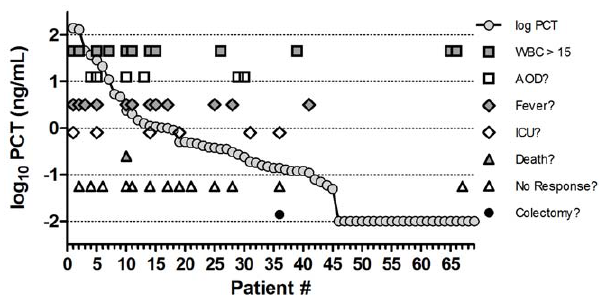
Figure 2. Procalcitonin (PCT) levels and presence of severity markers. This graph shows that patients with elevated PCT levels have an abundance of severity markers, while those with low or undetectable PCT levels have few. Patients are ordered by decreasing log 10 PCT value. ( WBC : white blood cell; AOD : acute organ dysfunction; ICU : intensive care unit).